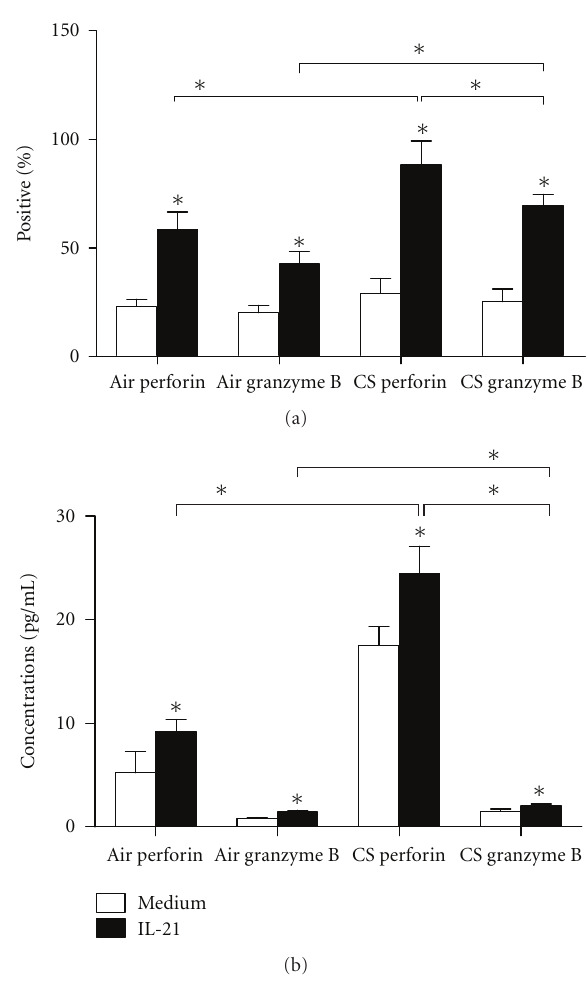
Figure 8: IL-21 upregulates perforin and granzyme B expression and protein levels in CD8 + T cells. The purified CD8 + T cells were cultured in the presence of PHA (10ng/mL) and rIL-21(50ng/mL) or PHA (10 ng/mL) alone for 3 days and analyzed for (a) perforin and granzyme B expression in CD8 + T cells of air-exposed and CS- exposed mice ( n = 10). (b) Perforin and granzyme B concentrations in CD8 + T cells of air-exposed and CS-exposed mice ( n = 10). Significance was determined by independent-samples t